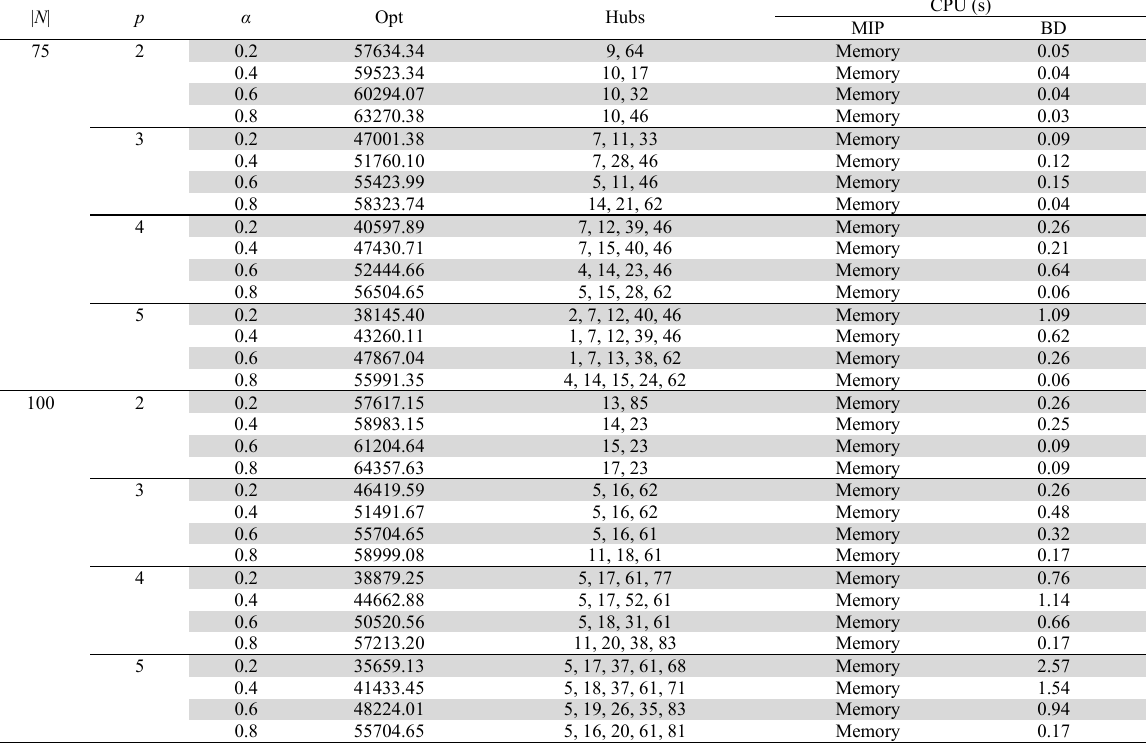
Results for solving the problem for the AP data set (medium instances)